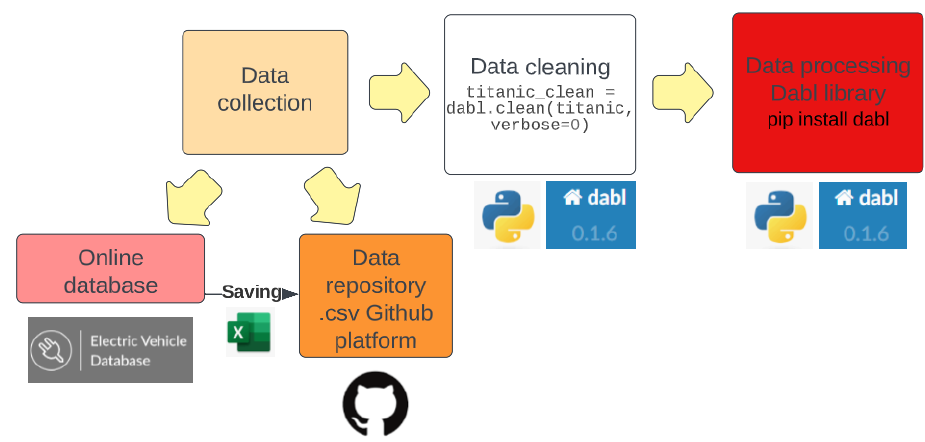
Figure 4. Flowchart for data processing in Python.